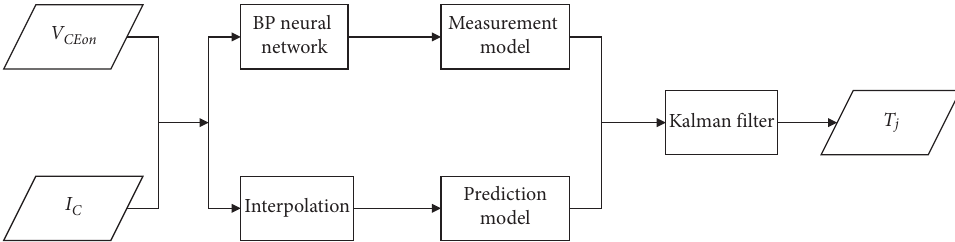
Figure 1: Block diagram of the methods for predicting junction temperature.